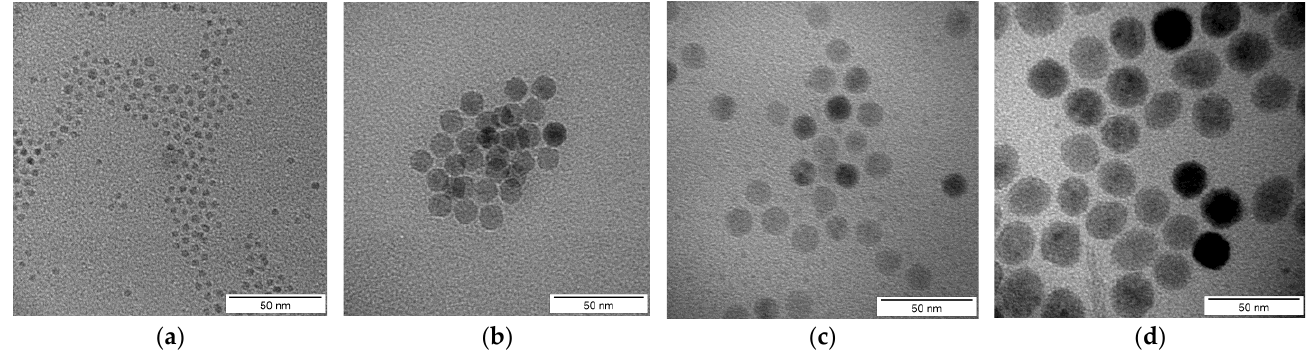
Figure 1. TEM image of 5 nm ( a ), 10 nm ( b ), 15 nm ( c ) and 20 nm ( d ) Fe 3 O 4